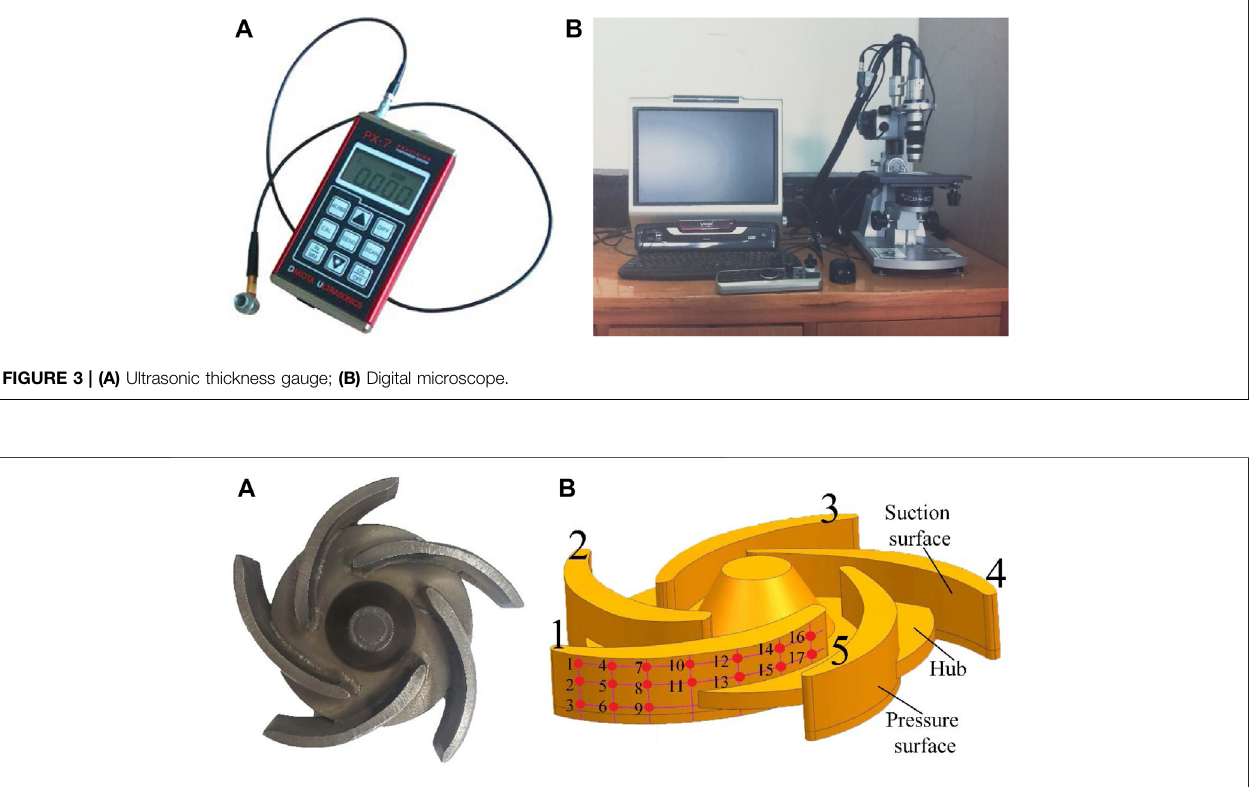
point is related to the different mass concentration. The wear is more serious at the middle and trailing edge of the blade; this is because the solid particles are affected by the vortex fl ow in the